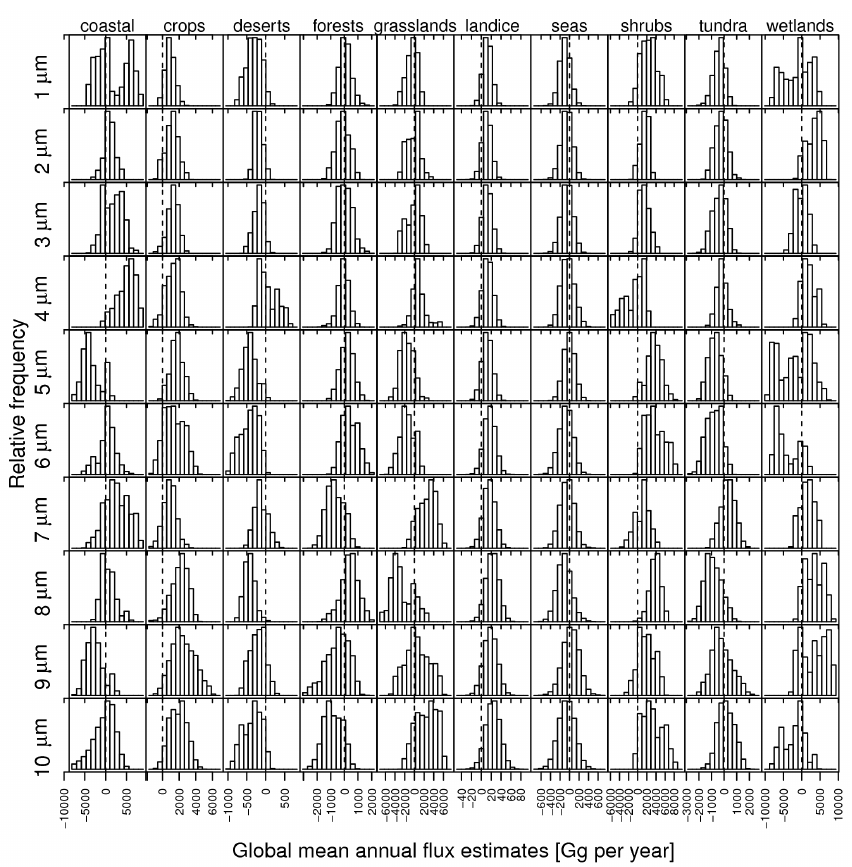
Fig. 3. Histograms of flux estimates, as in Fig. 2. Here, for CCN-ACTIVE particles in NO-PRIOR, with Gaussian data uncertainty and no prior constraint on fluxes. The vertical dashed lines indicate the position of zero estimated flux in each column.